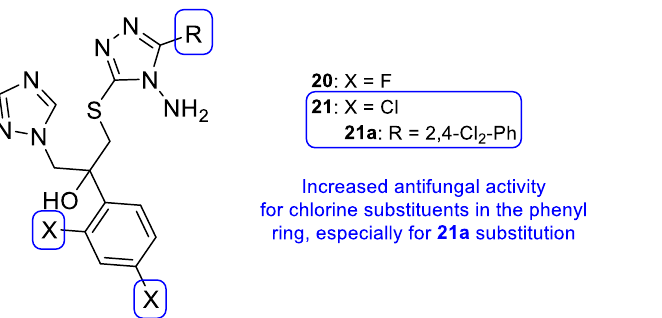
Figure 17. Scaffold for the difluoro- ( 20 ) and dichloro- ( 21 ) phenylethyl-triazole series, as well as the structure for compound 21a and respective SAR [97] .